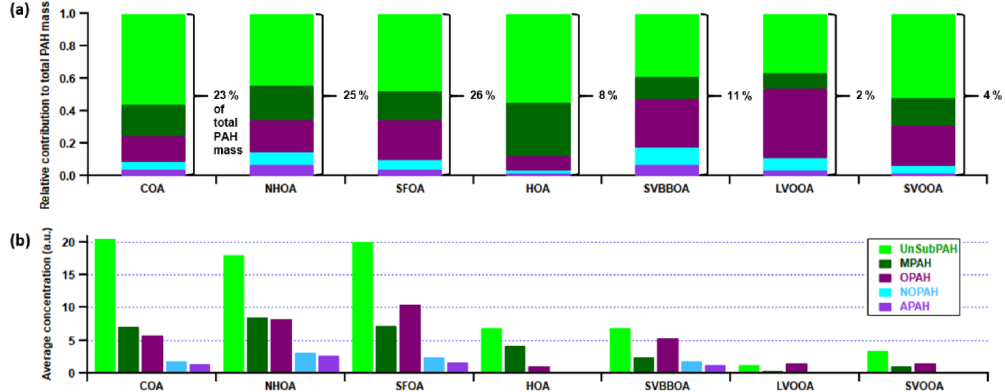
Figure 10. Relative contribution of PAH families to total PAH factor mass (a) and the PAH family average uncalibrated concentrations (b) . The PAH families – UnSubPAH, MPAH, OPAH, NOPAH and APAH – are described within Sect. S6 and in Herring et al.